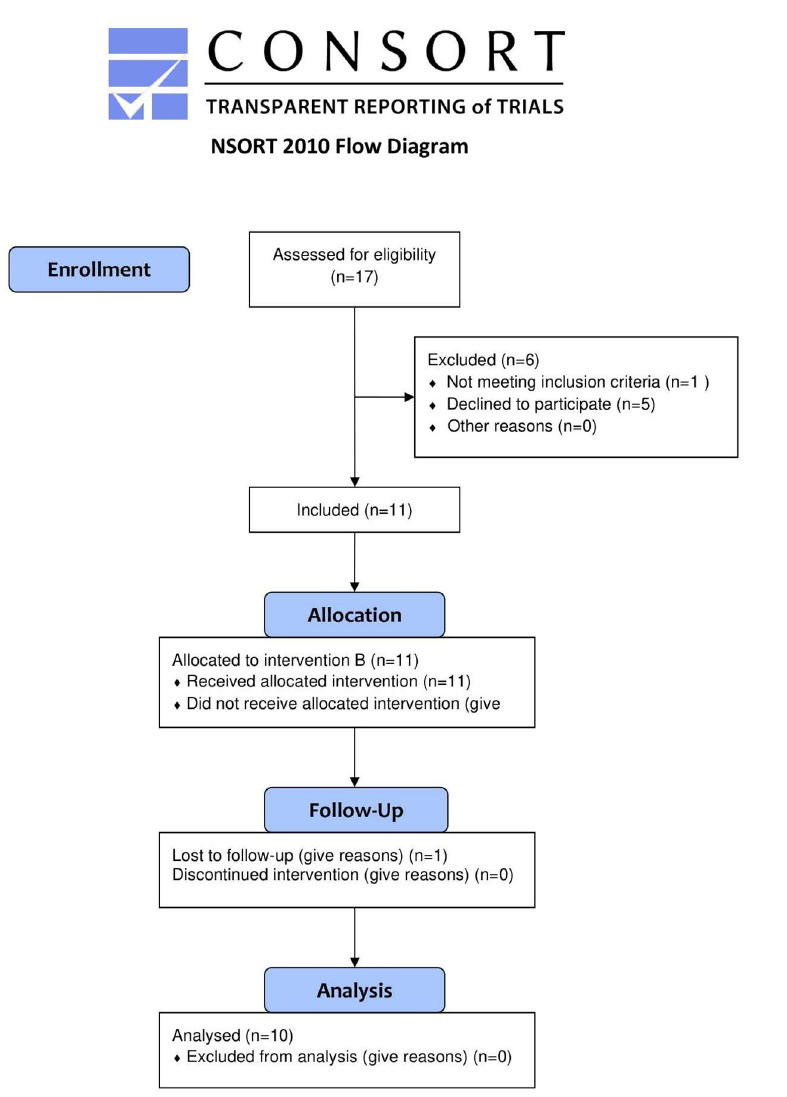
Fig 1. Flow diagram of recruitment of the